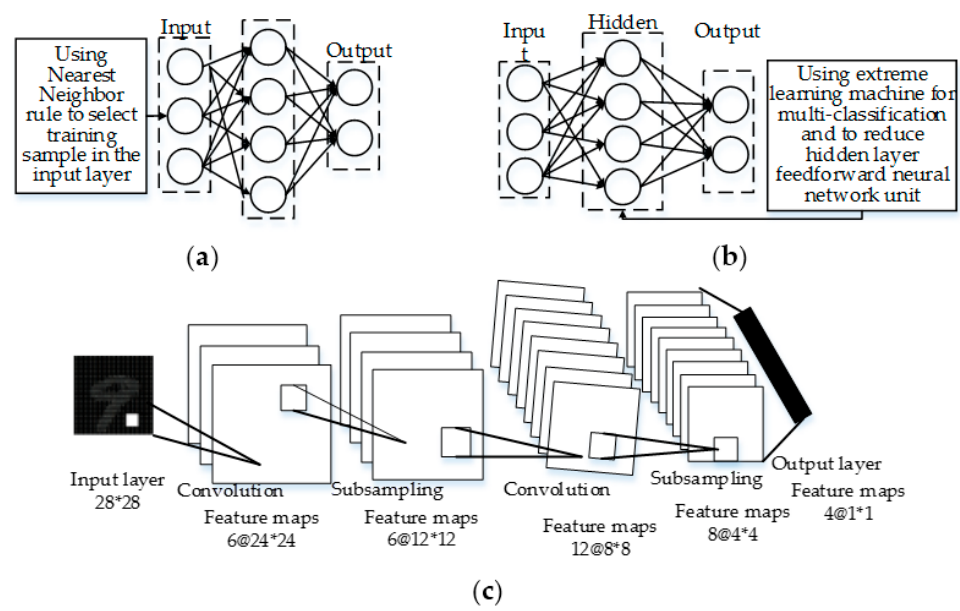
Figure 6. Convolution neural network structure model of comparison algorithms. ( a ) WCNN; ( b ) MLP-CNN; ( c )